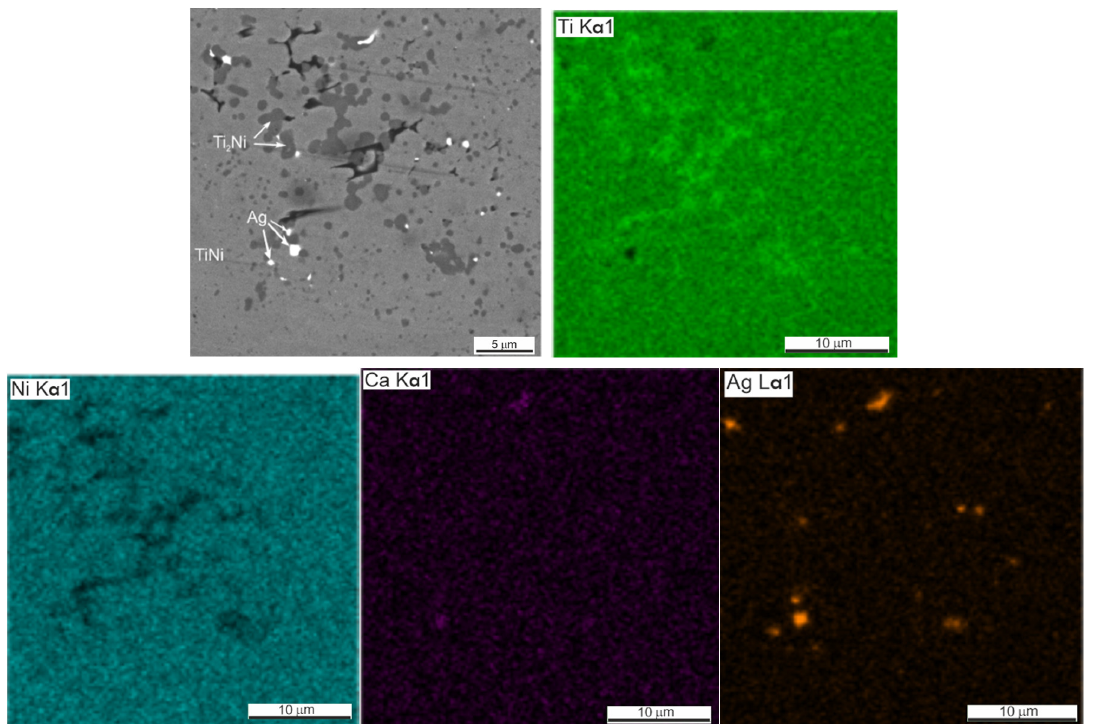
Figure 6. SEM image and EDS elemental mapping of porous SHS alloy TiNi + 0.5% Ag. Table 3. Elemental composition of phases in SHS alloys TiNi + 0.2% Ag. Ti, at.%